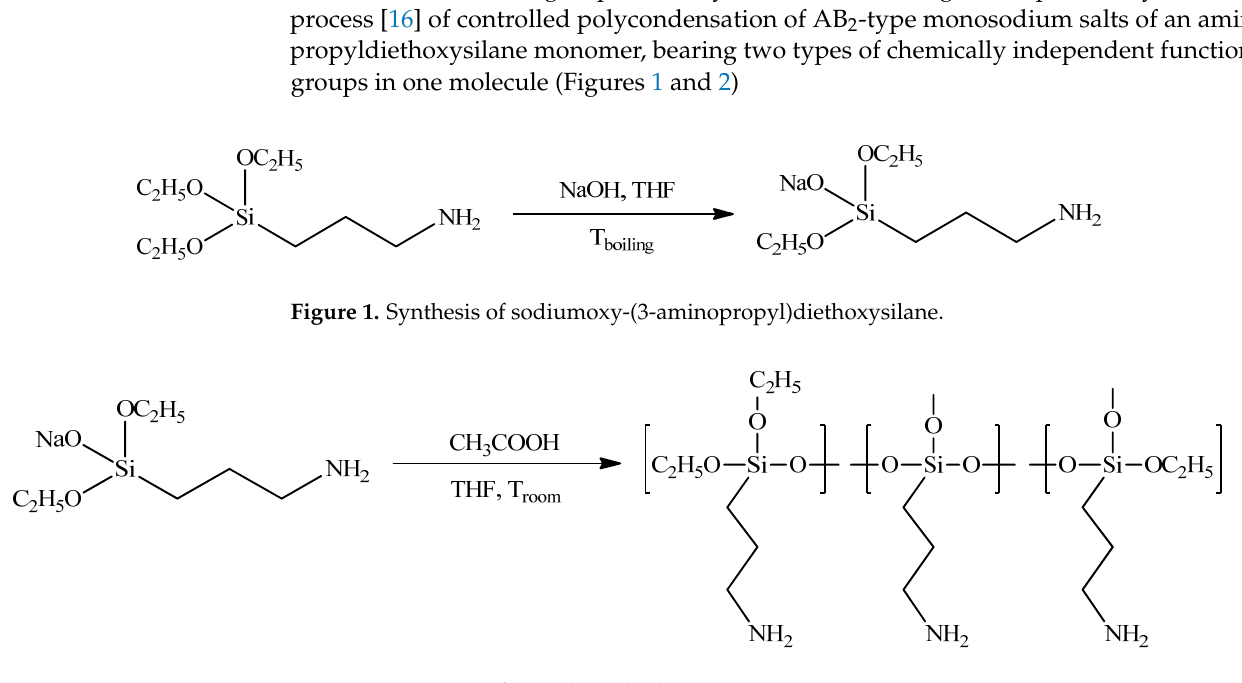
Figure 2. Synthesis of hyperbranched poly(3 ‐ aminopropyl)ethoxysiloxane. 1 H and 29 Si NMR spectroscopies were used for the characterization of the molecular